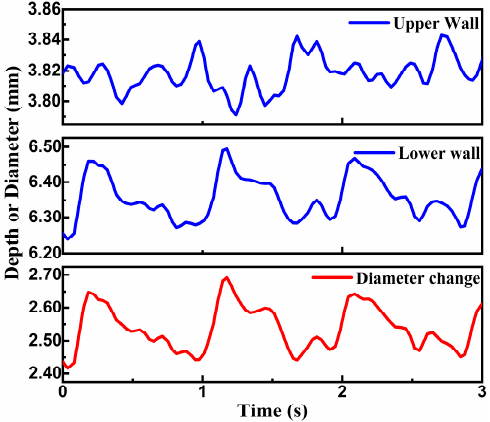
Figure 11. Dynamic depth change of two artery walls and diameter change.